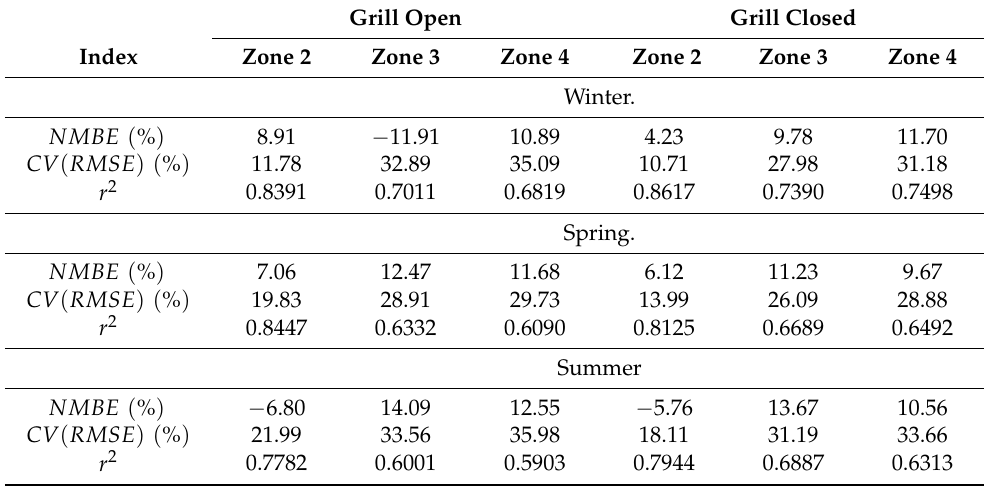
Table 9. Two-dimensional (2D) simulation. Values of the statistical indicators for air temperature.